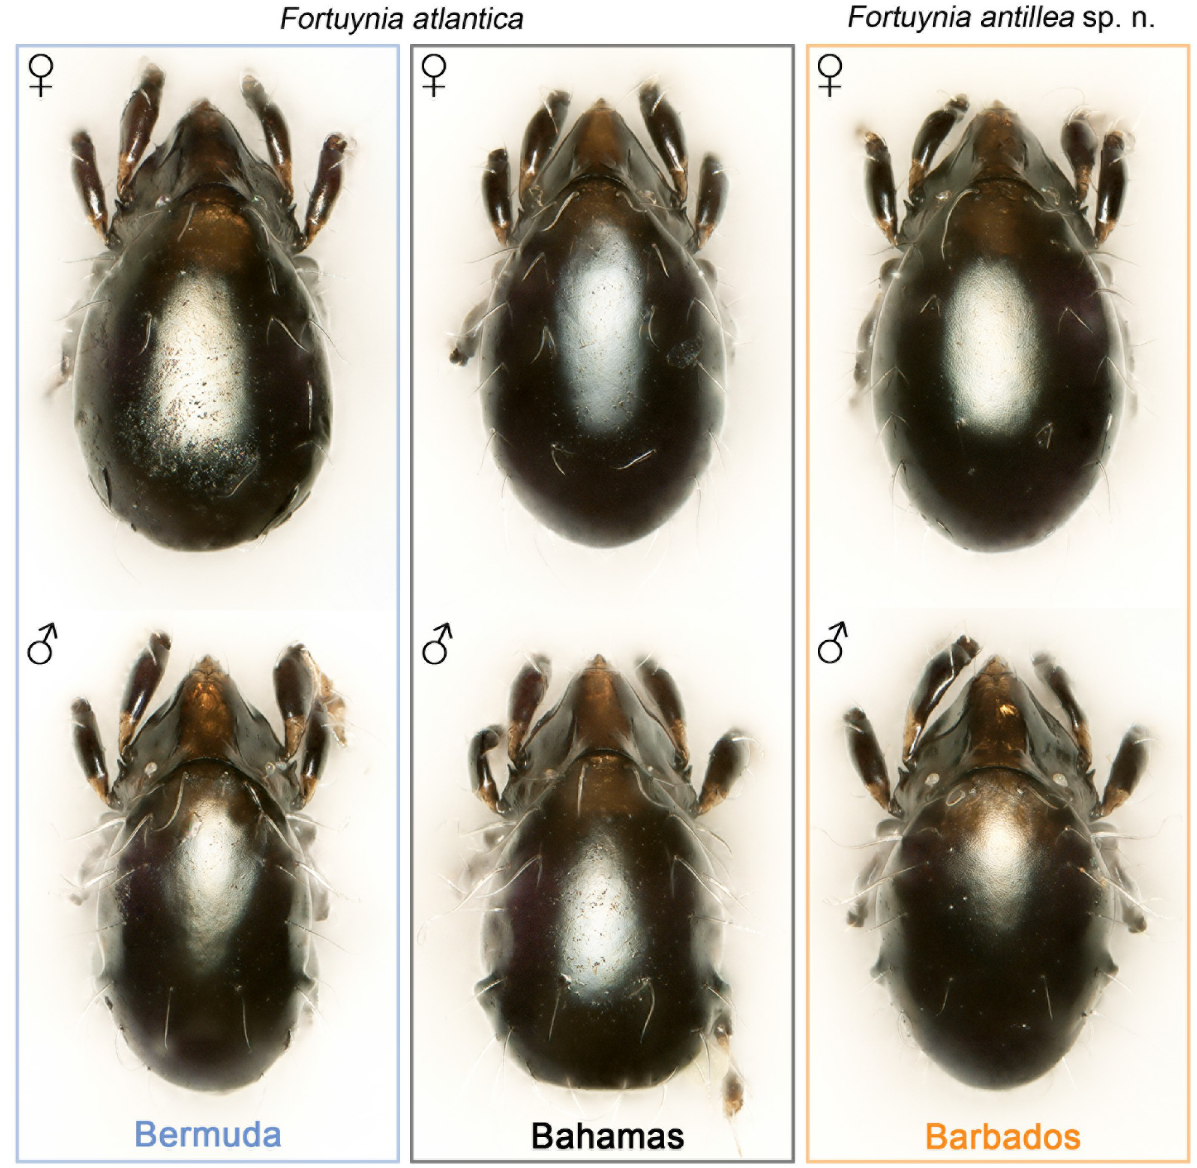
Fig 7. Photographic comparison of Caribbean Fortuynia species/populations from three different locations illustrating the lack of phenotypic differences. Stacked stereomicroscopic images in dorsal view; upper row female, lower row male specimens. (White spot on the notogaster is a light artifact / reflected light